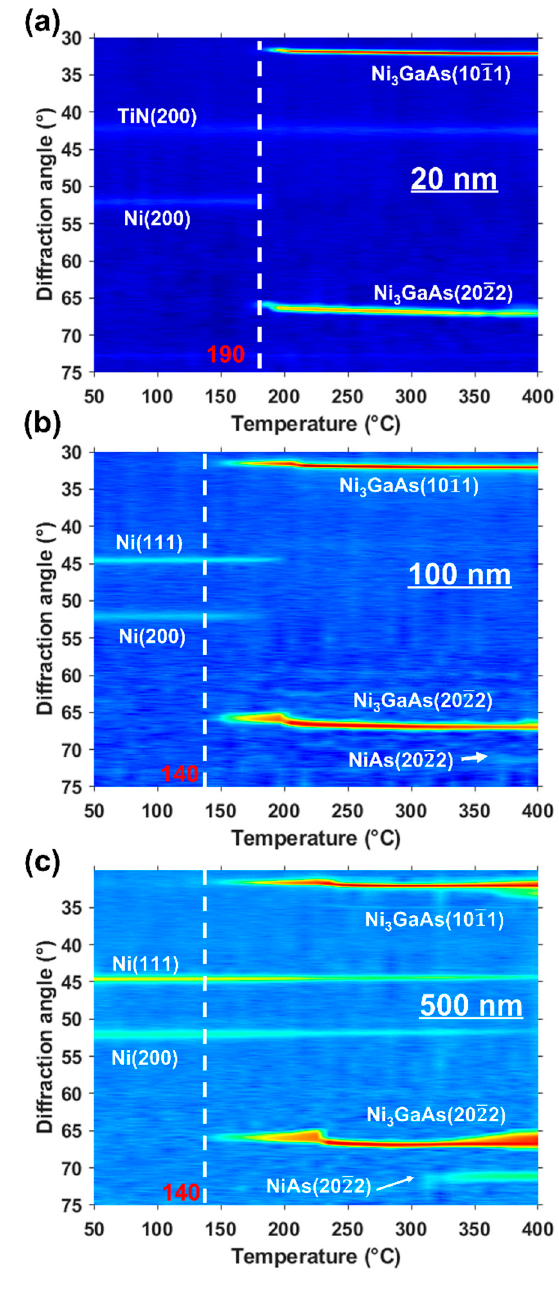
Figure 3. In situ XRD diagrams ( λ = 1.5418 Å) recorded for: ( a ) 20 nm; ( b ) 100 nm; and ( c ) 500 nm Ni on GaAs (100) during an annealing between 50 °C and 400 °C.